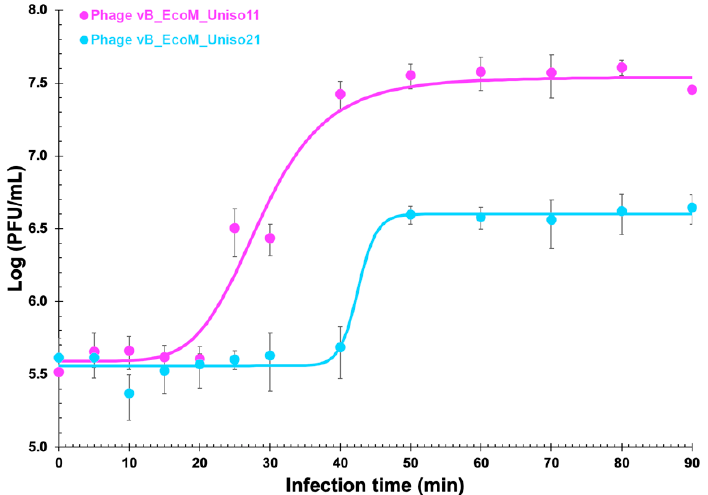
Figure 2. One-step growth curve analysis of phages vB_EcoM_Uniso11 and vB_EcoM_Uniso21 on an exponential culture of E. coli . Solid lines represent the non-linear fittings of the 4-PL model to the experimental data. Values are the means of three independent assays; Error bars represent the standard deviations.